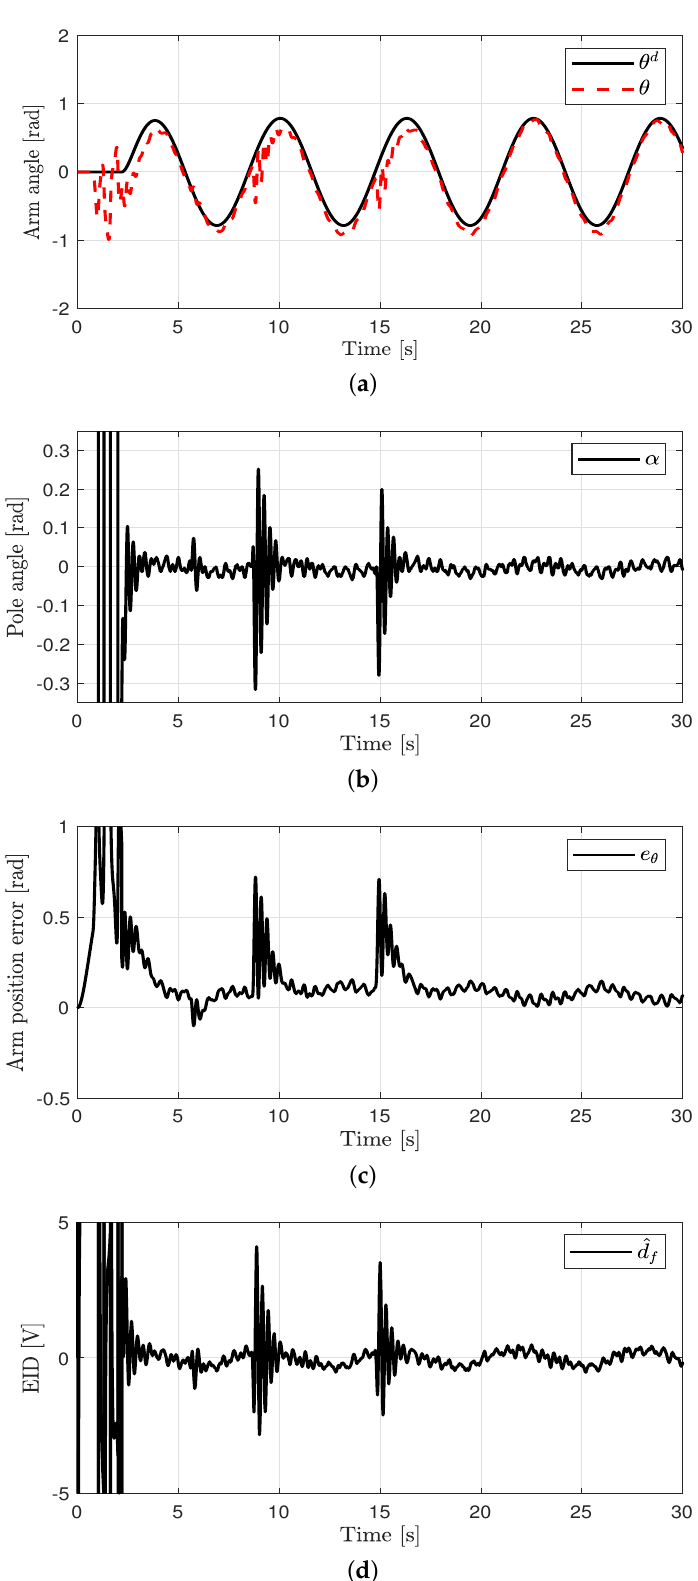
Figure 8. Control performance of the proposed method under the external disturbance. ( a ) Arm position (case 4). ( b ) Pendulum pole position (case 4). ( c ) Arm position error (case 4). ( d ) Estimated EID (case